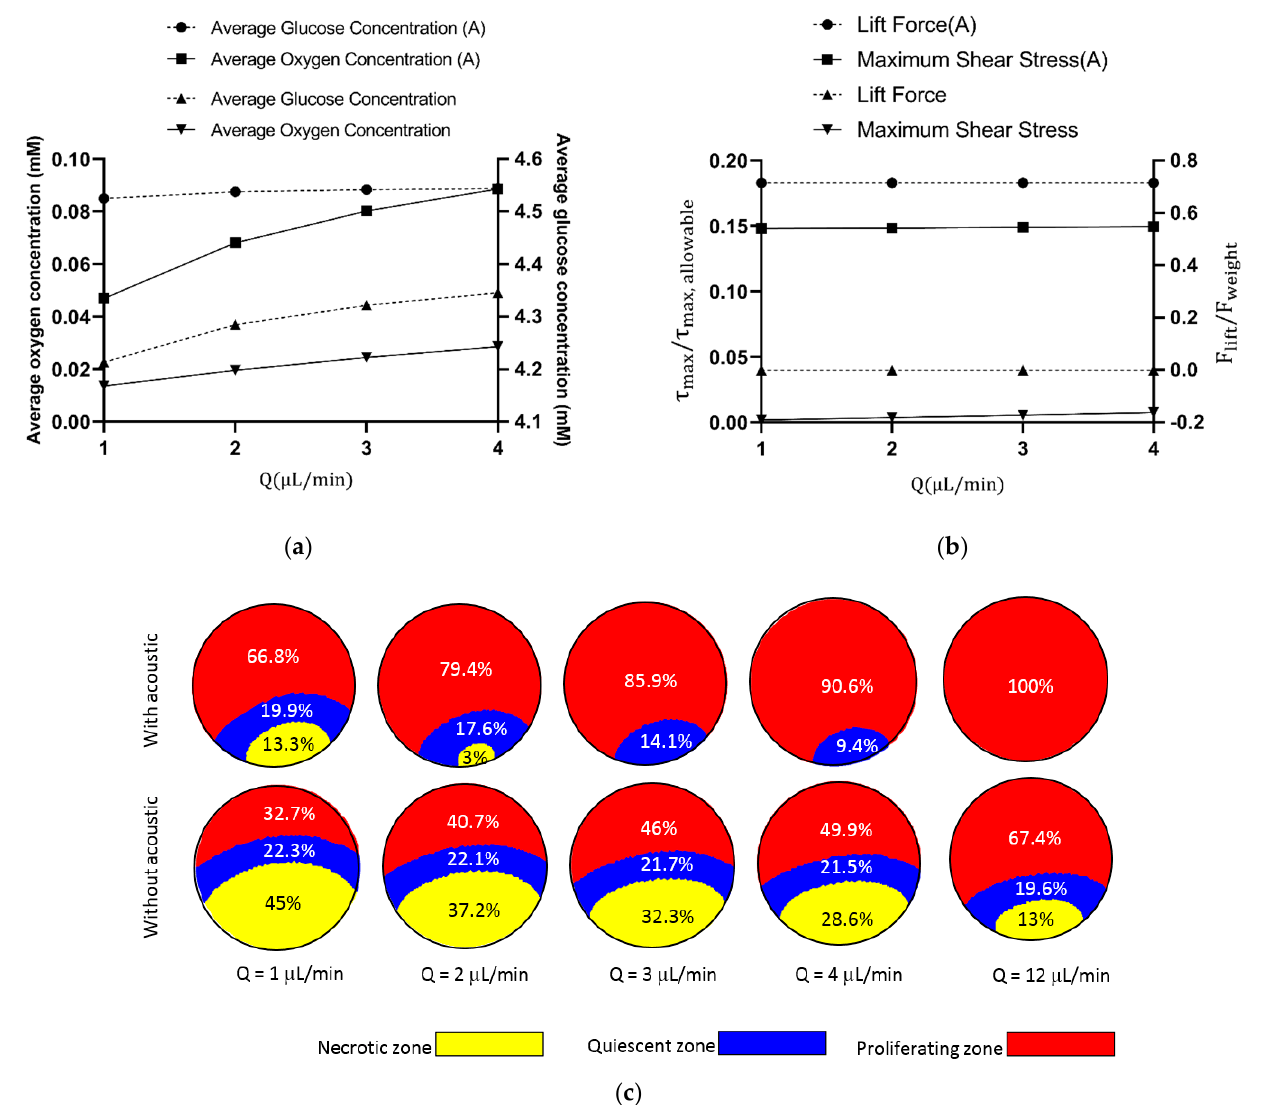
Figure 8. ( a ) Effect of flow rate on oxygen/glucose concentration with/without acoustics. As shown in the figure, the acoustic field enhanced concentrations greatly without the need for any increases in the flow rate. ( b ) A study of the effect of flow rate and acoustic integration to the system on maximum fluid shear stress and the lift force. The acoustic wave is amplifying these two parameters, but they are still in the safe range for this application. ( c ) A comparison in necrotic/quiescent shrinkage with a flow rate between acoustic and non-acoustic modes. Increasing the flow rate helps the growth of the proliferation zone. The acoustic field solely can perform better without the need for any increases in the flow rate. Approximately, acoustics improves the proliferating zone by 100% at each flow